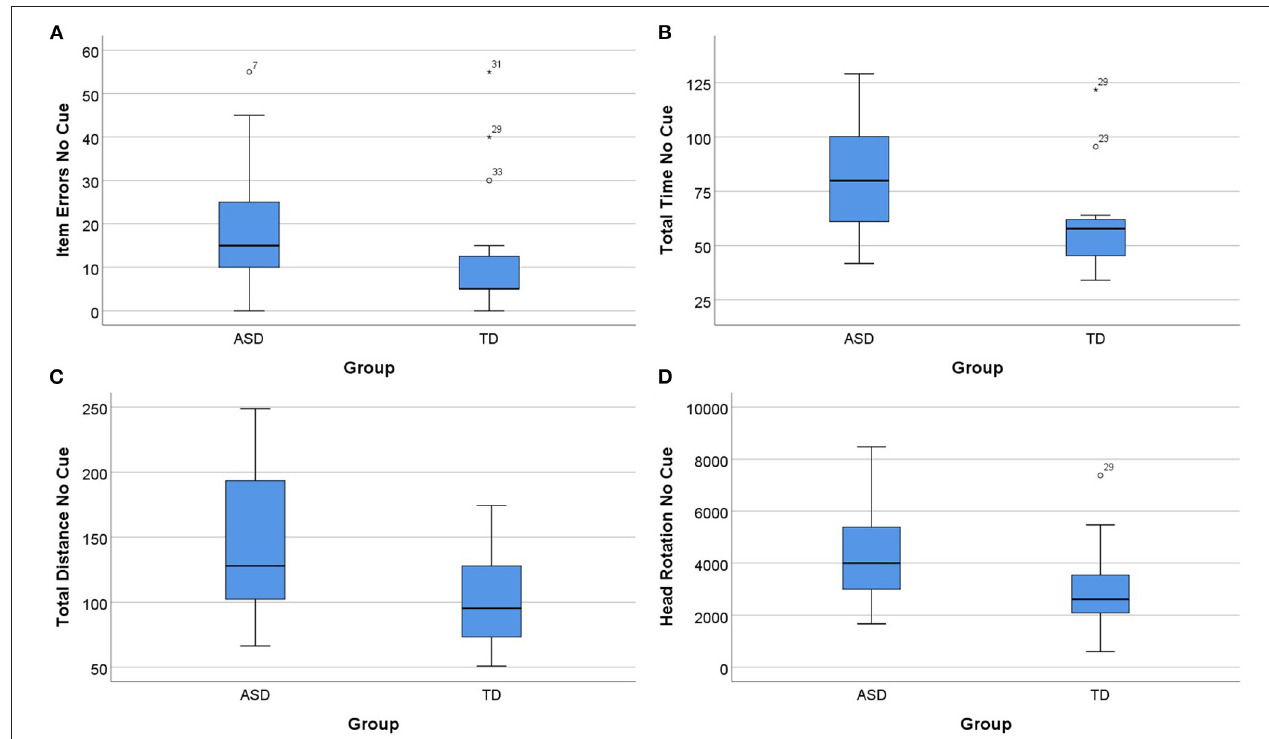
FIGURE 4 | Significant group differences were observed in the no cue condition ( p < 0.05). (A) Mean percentage of item errors for ASD and TD groups for the no cue condition. (B) Total time for ASD and TD groups for the no cue condition. (C) Total distance for ASD and TD groups for the no cue condition. (D) Head rotation for ASD and TD groups for the no cue condition. Boxplots: central mark—median; edges of box − 25th and 75th percentiles; whiskers—most extreme data points (minimum and maximum). ASD, autism spectrum disorder group; TD, typical neurodevelopment group. The symbol * is the representation of an extreme